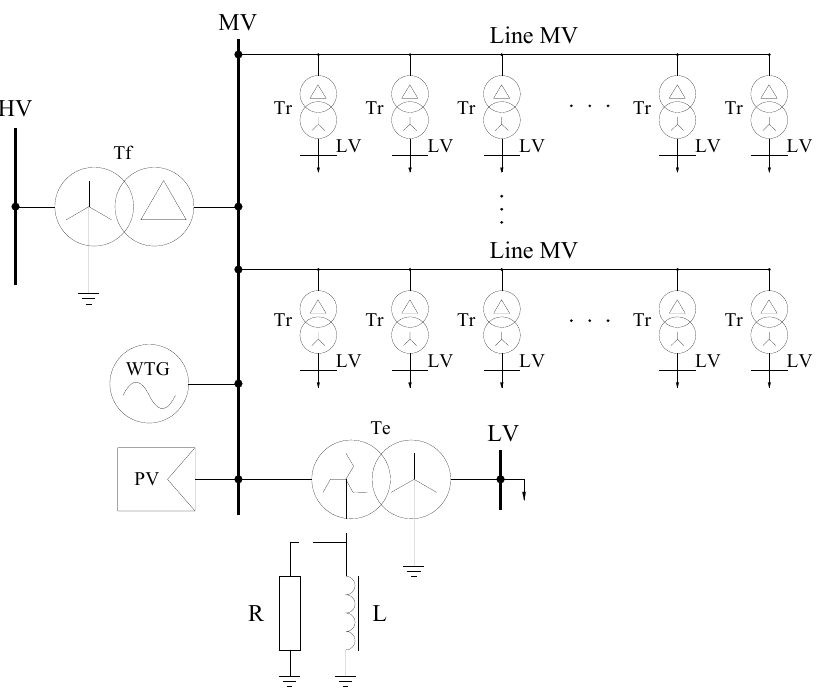
Figure 2. General diagram of MV power network supplied from HV/MV substation. HV—high voltage, MV—medium voltage, LV—low voltage, Tf—feeder transformer, Tr—receiving transformer, Te—earthing transformer, WT—wind turbine generator, PV—photovoltaic power plant, R—resistor earthing the neutral point of the transformer, L—inductance (coil) earthing the neutral point of the transformer.